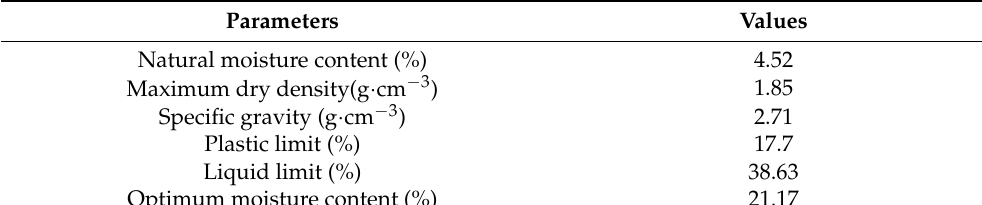
Table 1. Physical property parameters of the loess.